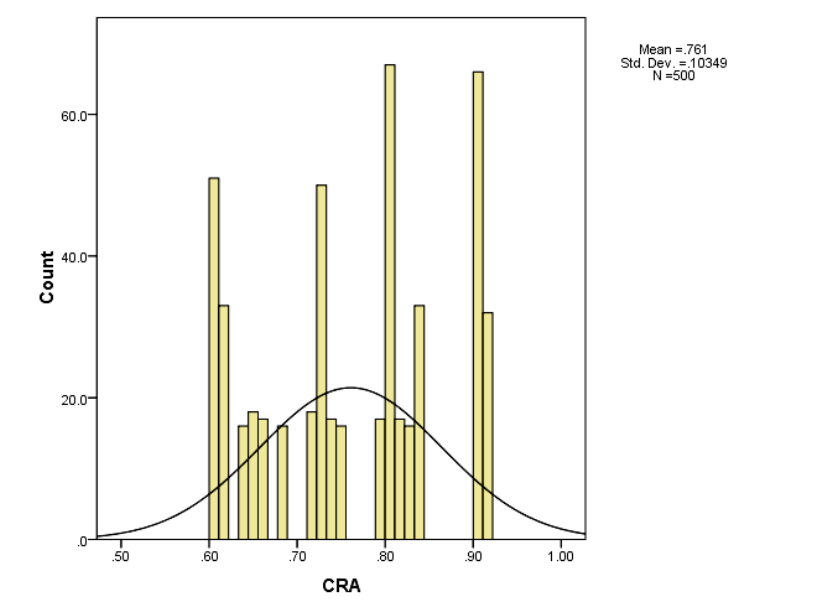
Figure 2. Histogram of regression standardized